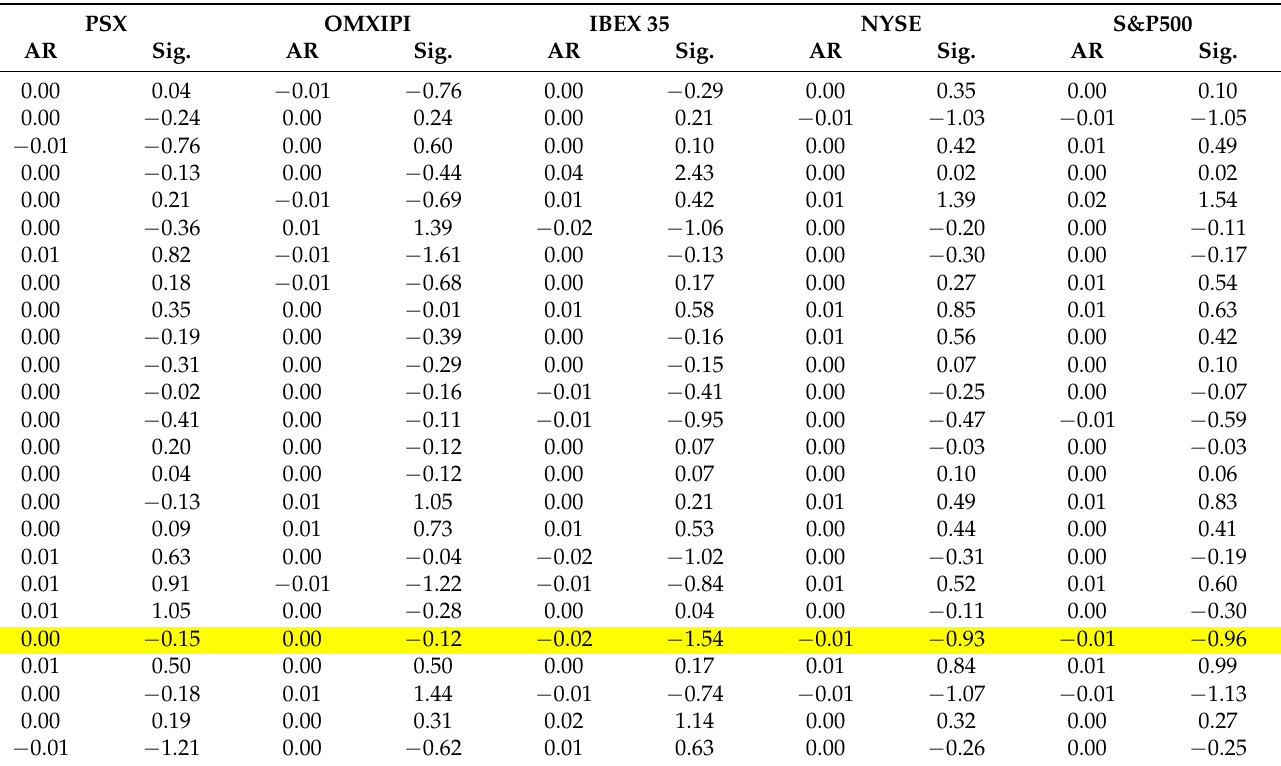
Table A11. Abnormal returns of the ( − 20, +20) event window (Prime Minister of Iceland announced his